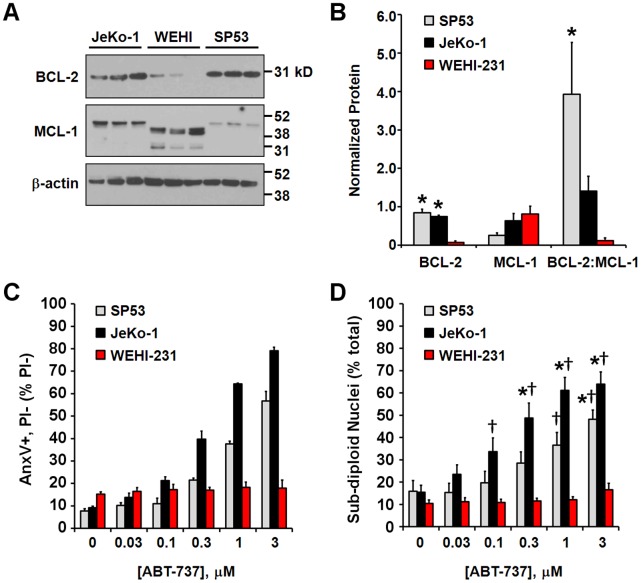
SP53 and JeKo-1 lymphoma cells exhibit a high BCL-2:MCL-1 ratio and a primed phenotype.(A) Expression levels of BCL-2 and MCL-1 relative to β-actin loading control in B-cell lymphoma cell lines. Mouse MCL-1 protein (WEHI-231) is known to migrate faster than the human form of the protein (SP53 and JeKo-1). (B) BCL-2 or MCL-1 protein levels normalized to β-actin and BCL-2:MCL-1 ratios following densitometric analysis of the immunoblots in A. Only the upper MCL-1 band corresponding to the full length protein was used for quantification. Results are mean ± SD, n = 3. *p<0.05 relative to WEHI-231 cells. (C) Early apoptosis, expressed as the percentage of PI negative cells that were AnxV-positive after 4 h of treatment with vehicle control or the indicated concentration of ABT-737. Results are mean ± SD of one experiment performed in triplicate. (D) Apoptosis, as determined by the percentage of sub-diploid nuclei. Results are mean ± SE of three (SP53) or five (JeKo-1 and WEHI-231) experiments performed in triplicate. *p<0.05 for ABT-737-treated relative to control-treated; †p<0.05 relative to WEHI-231 cells treated with the same concentration of ABT-737.